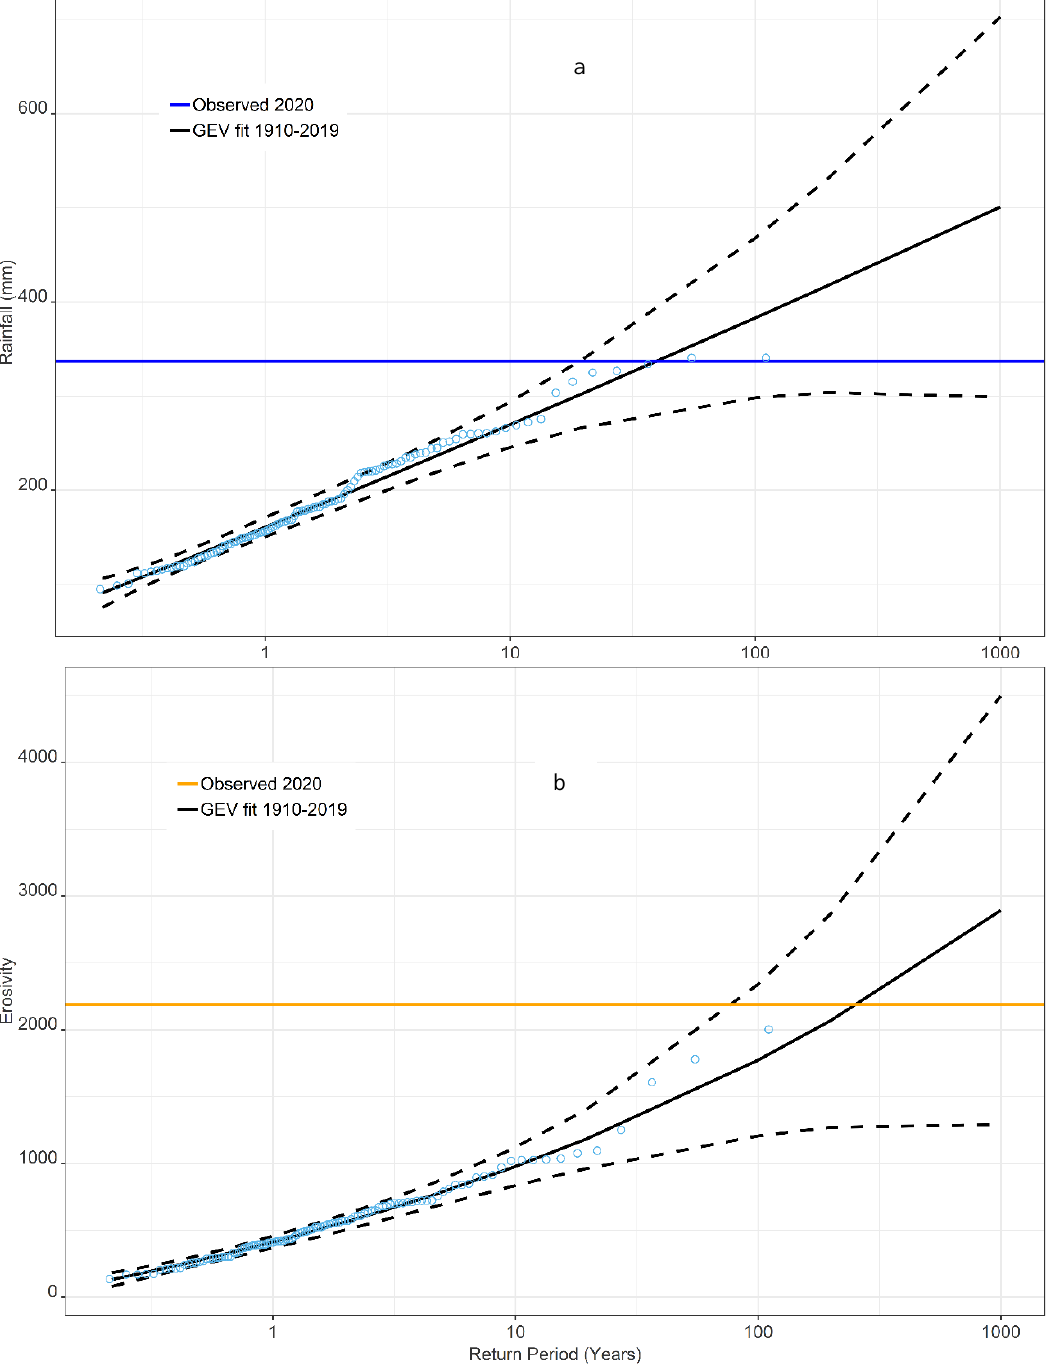
Figure 3. The return periods for the 2019–2020 post-fire in the Sydney drinking water catchment area: ( a ) Rainfall; ( b ) rainfall erosivity. The circles indicate return periods for the annual maximum rainfall based on the 1910–2019 climate; the dash lines are the corresponding ± 1.96 × standard error at the 95% confidence level.